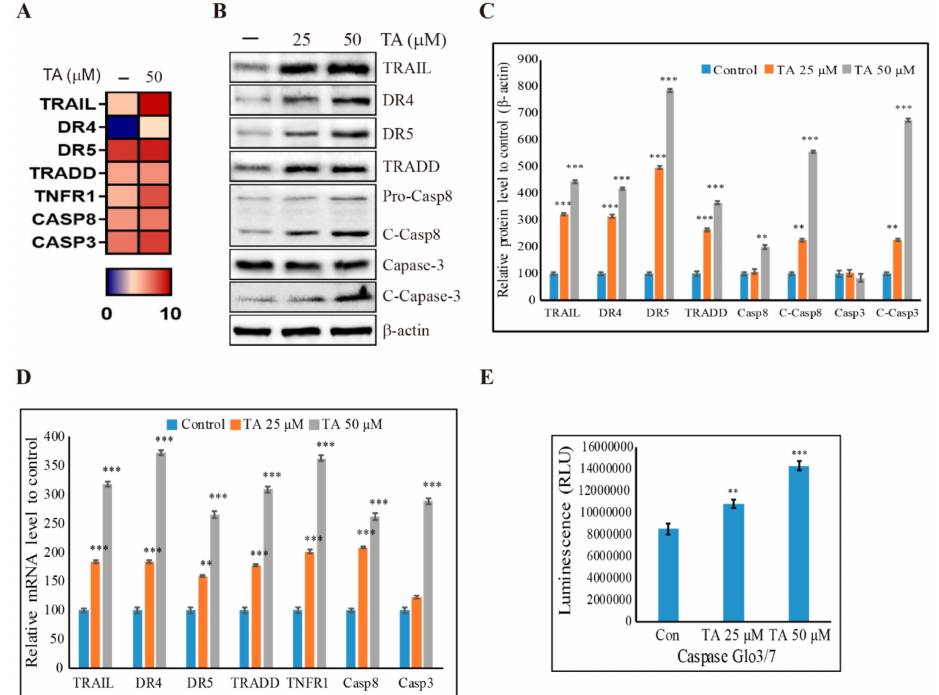
Figure 6. TA induces extrinsic apoptosis in NCCIT cells. ( A ) Heat map showing the fold changes relative to the mean expression of extrinsic apoptosis pathway in non-treated and TA-treated NCCIT cells. ( B ) Western blotting analysis of NCCIT cells with 25 µ M and 50 µ M of TA for 48 h showing the inhibition of extrinsic apoptotic protein expressions. ( C ) The representative expressions of proteins were determined via densitometry and normalized to β -actin. Controls are set to 100. Data are representative of three independent experiments. ** p < 0.01 and *** p < 0.001 ( t -test). ( D ) Real-time PCR data of mRNA after treatment with TA showing the relative expression levels of the extrinsic apoptosis pathway and normalized to GAPDH mRNA. Controls are set to 100. Data are representative of three independent experiments. ** p < 0.01 and *** p < 0.001 ( t -test). ( E ) Caspase-Glo 3 / 7 assay showing the enhancement of caspase-3 and caspase-7 activity with TA treatment for 24 h. ** p < 0.01 and *** p < 0.001 ( t